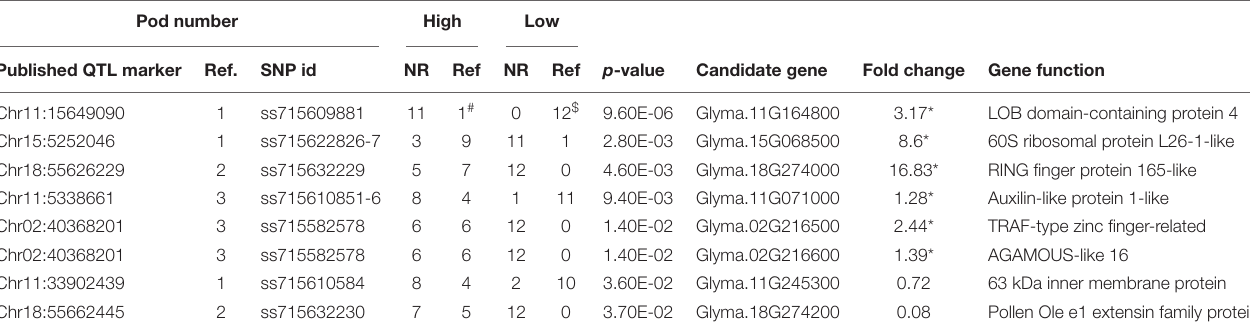
TABLE 2 | Candidate genes associated with pod